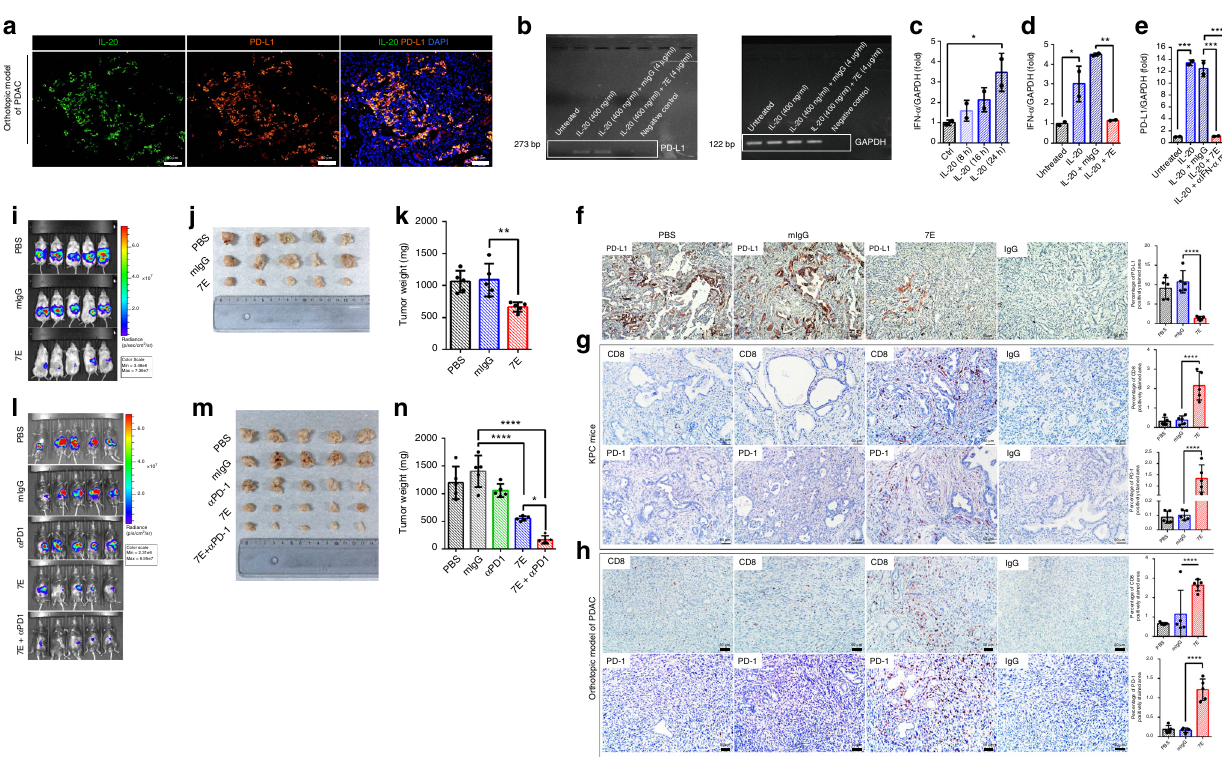
Fig. 4 IL-20 induced PD-L1 expression, and 7E neutralized IL-20-induced PD-L1 expression. a Pancreatic tissue from an orthotopic PDAC model mouse was analyzed by immuno fl uorescence labeling of IL-20 (green) and PD-L1 (red). Nuclei (blue) were visualized by DAPI staining. Scale bar, 50 μ m. b KPC cells were treated with IL-20 or IL-20 plus 7E, and the expression of PD-L1 in the KPC cells was analyzed using RT-PCR with speci fi c primers. c KPC cells were treated with mIL-20 for the indicated time, and the fold increase in the expression of IFN- α was analyzed using RT-qPCR with speci fi c primers ( n = 1 strain of cell culturing; one-way ANOVA, p = 0.0488). d IFN- α mRNA expression ( n = 1 strain of cell culturing; one-way ANOVA, p < 0.0001) and e PD- L1 mRNA expression in KPC cells were analyzed after IL-20 treatment using RT-qPCR ( n = 1 strain of cell culturing; one-way ANOVA, p = 0.0042). * p < 0.05, ** p < 0.01, and *** p < 0.001. KPC mice and orthotopic PDAC model mice were treated with 7E, and pancreatic tissue samples were analyzed for f PD-L1 (one-way ANOVA, p < 0.0001), g , h CD8, and PD-1 staining quanti fi cation. The rightmost panel shows the IgG-stained negative control. Scale bar, 50 μ m. g CD8 and PD-1: one-way ANOVA, p < 0.0001. h CD8 and PD-1: one-way ANOVA, p < 0.0001. **** p < 0.001 compared with the mIgG-treated controls. KPC/Luc cells were injected into the pancreas of WT mice. PBS, mIgG, an anti-PD-1 antibody, 7E, or 7E + the anti-PD-1 antibody ( n = 5) were injected (i.p.) into the mice twice per week for 28 days. i Analysis of tumor growth by using the in vivo luminescence activity of KPC/Luc cells on day 21. j , k Tumors were collected and weighed ( n = 5; one-way ANOVA, p = 0.005). l Luciferase activity was measured on day 21 posttreatment and used to quantify tumor growth. m , n Tumors were harvested and analyzed ( n = 5; one-way ANOVA, p < 0.0001). * p < 0.05, ** p < 0.01, and **** p < 0.0001. Values represent the mean ± SD. Statistical signi fi cance was determined by one-way ANOVA Sidak ’ s multiple comparisons test ( c – h , k , n ). The experiments in c – e were repeated three times independently with similar results, and the data of one representative experiment are